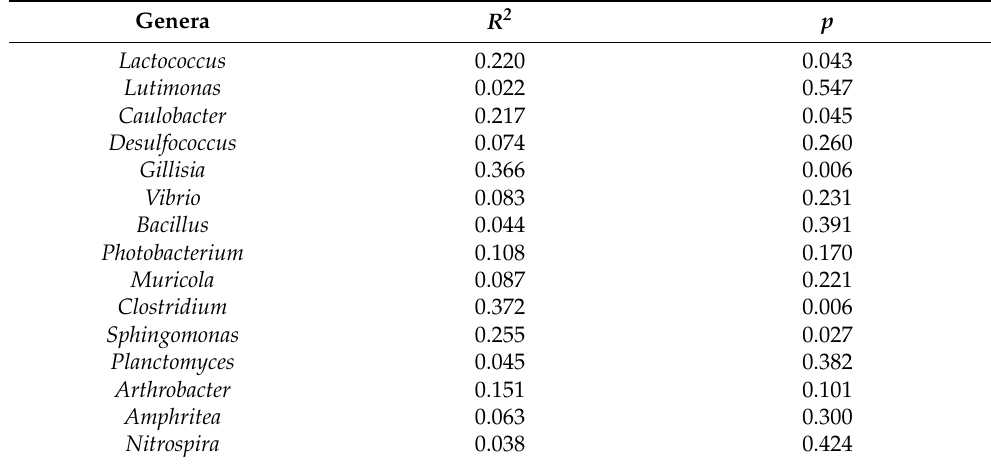
Table 3. Regression analysis between relative abundances of bacterial genera and geographical distance to the center of magnetite from 2